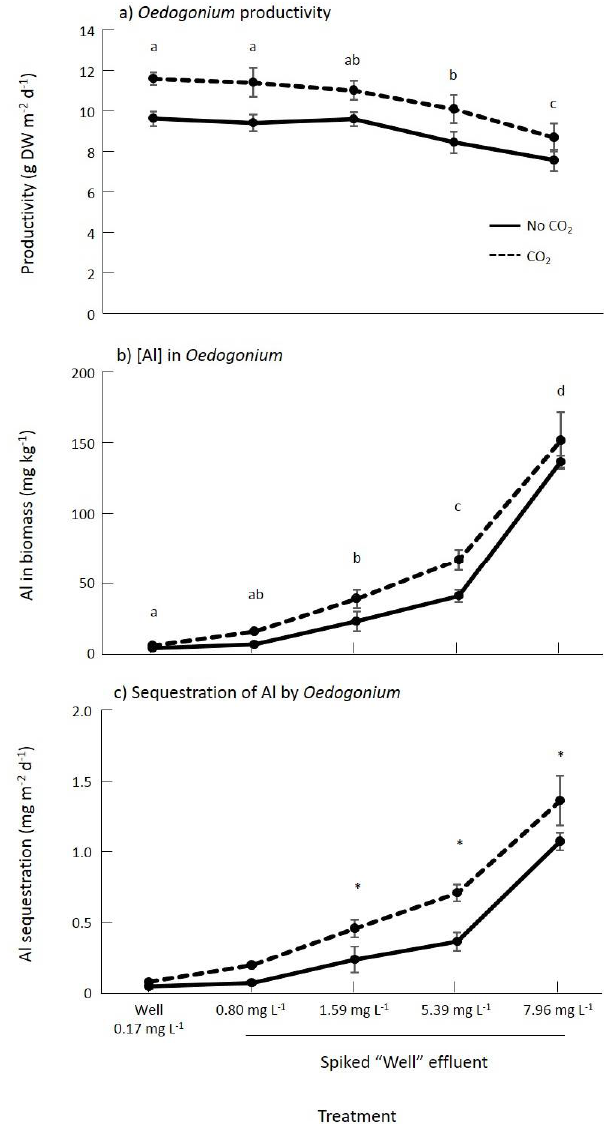
Figure 4. ( a ) Productivity of Oedogonium ; ( b ) concentration of Al in Oedogonium biomass; and ( c ) rate of sequestration of Al by Oedogonium from Giru waste water (“Well”) spiked with a range of Al concentrations. The solid lines show data for treatments without CO 2 and the dashed lines show data for treatments with CO 2 (see Figure 2 for pH profiles). The letters above treatments in panels ( a , b ) indicate the results of post-hoc Tukey’s tests for the factor “Al”. Treatments that share a common letter do not differ ( p > 0.05). The asterisks above treatments in panel ( c ) indicate the results of post-hoc Tukey’s tests for the interaction (“Al × CO 2 ”). Treatments marked with an asterisk differ in the CO 2 vs. no CO 2 comparison for that Al concentration. All data are means ± standard error ( n = 4).